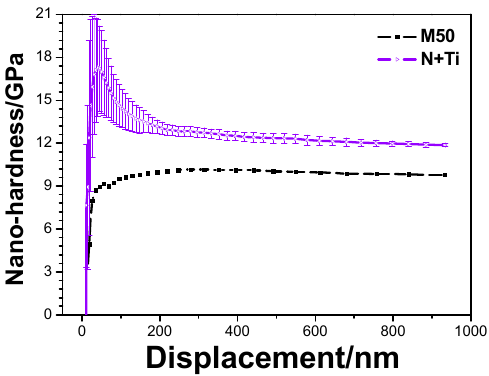
Figure 3. Nanoindentation curves of the samples before and after N + + Ti + ion implantation.